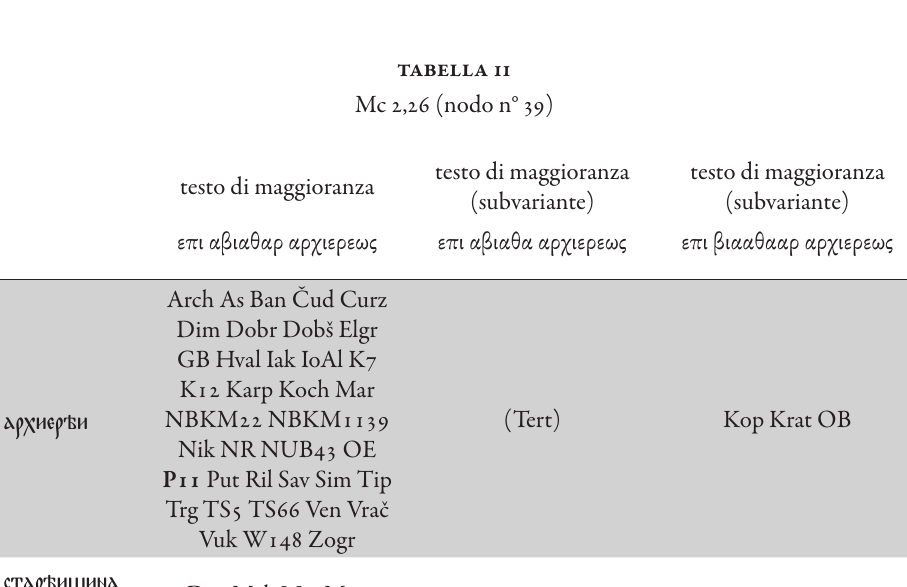
tradizione più antica: al prestito, caratteristico della versione paleoslava, si oppone il calco, presente in codici più tardi e particolarmente nei lezionari (ricordiamo che la ‘se- conda redazione’ di Voskresenskij – oggi impressionisticamente nota come ‘testo di Pre- slav’ – contemplava quasi esclusivamente lezionari feriali slavo-orientali). Nel Vangelo di Mstislav ci sono 47 occorrenze del termine innovativo (il calco) e 58 del prestito. A fron- te di questa situazione ‘ibrida’ (caratteristica della maggior parte dei codici che usano il termine innovativo), P11 utilizza sempre il lessema arcaico ( архиерѣи ), anche dove Mst ha il calco (cfr. архи | ииѥрѣѧ sic Mt 2,4 f. 229r, иереомъ Mt 8,4 f. 65r, архиерѣи Mt 27,1 f. 161r, архииереи Mc 2,26 f. 119v, архииѥрѣи Lc 3,2 f. 235r; cfr. anche аръхи.соунагога